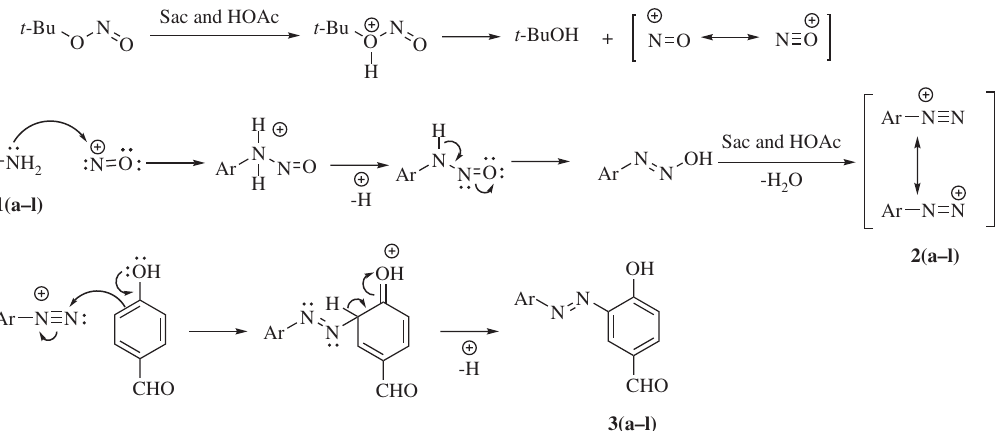
Scheme 2: The diazotization process of aryl amines in presence of saccharin and tert -butyl nitrite, followed by azo coupling reaction with